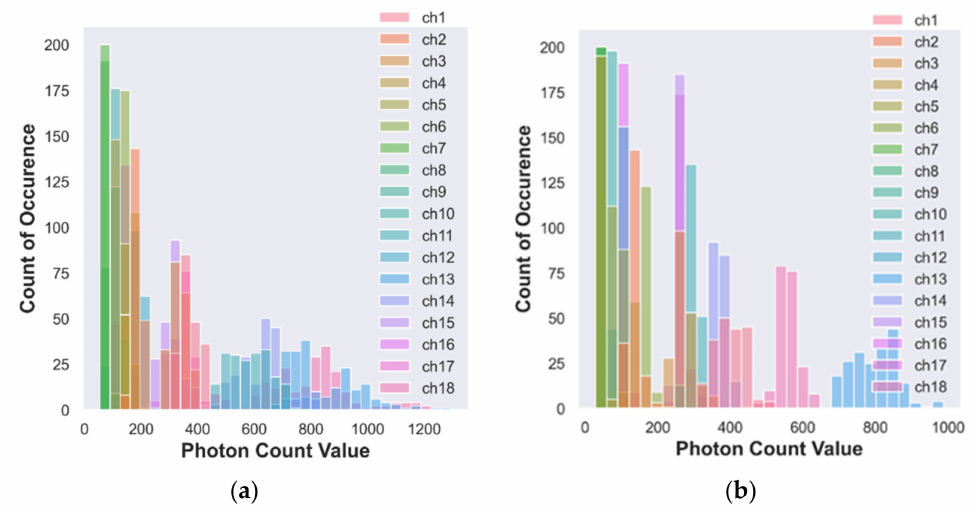
Figure 5. ( a ) Histogram of photon count for conventional brinjal; ( b ) histogram of photon count for organic brinjal.